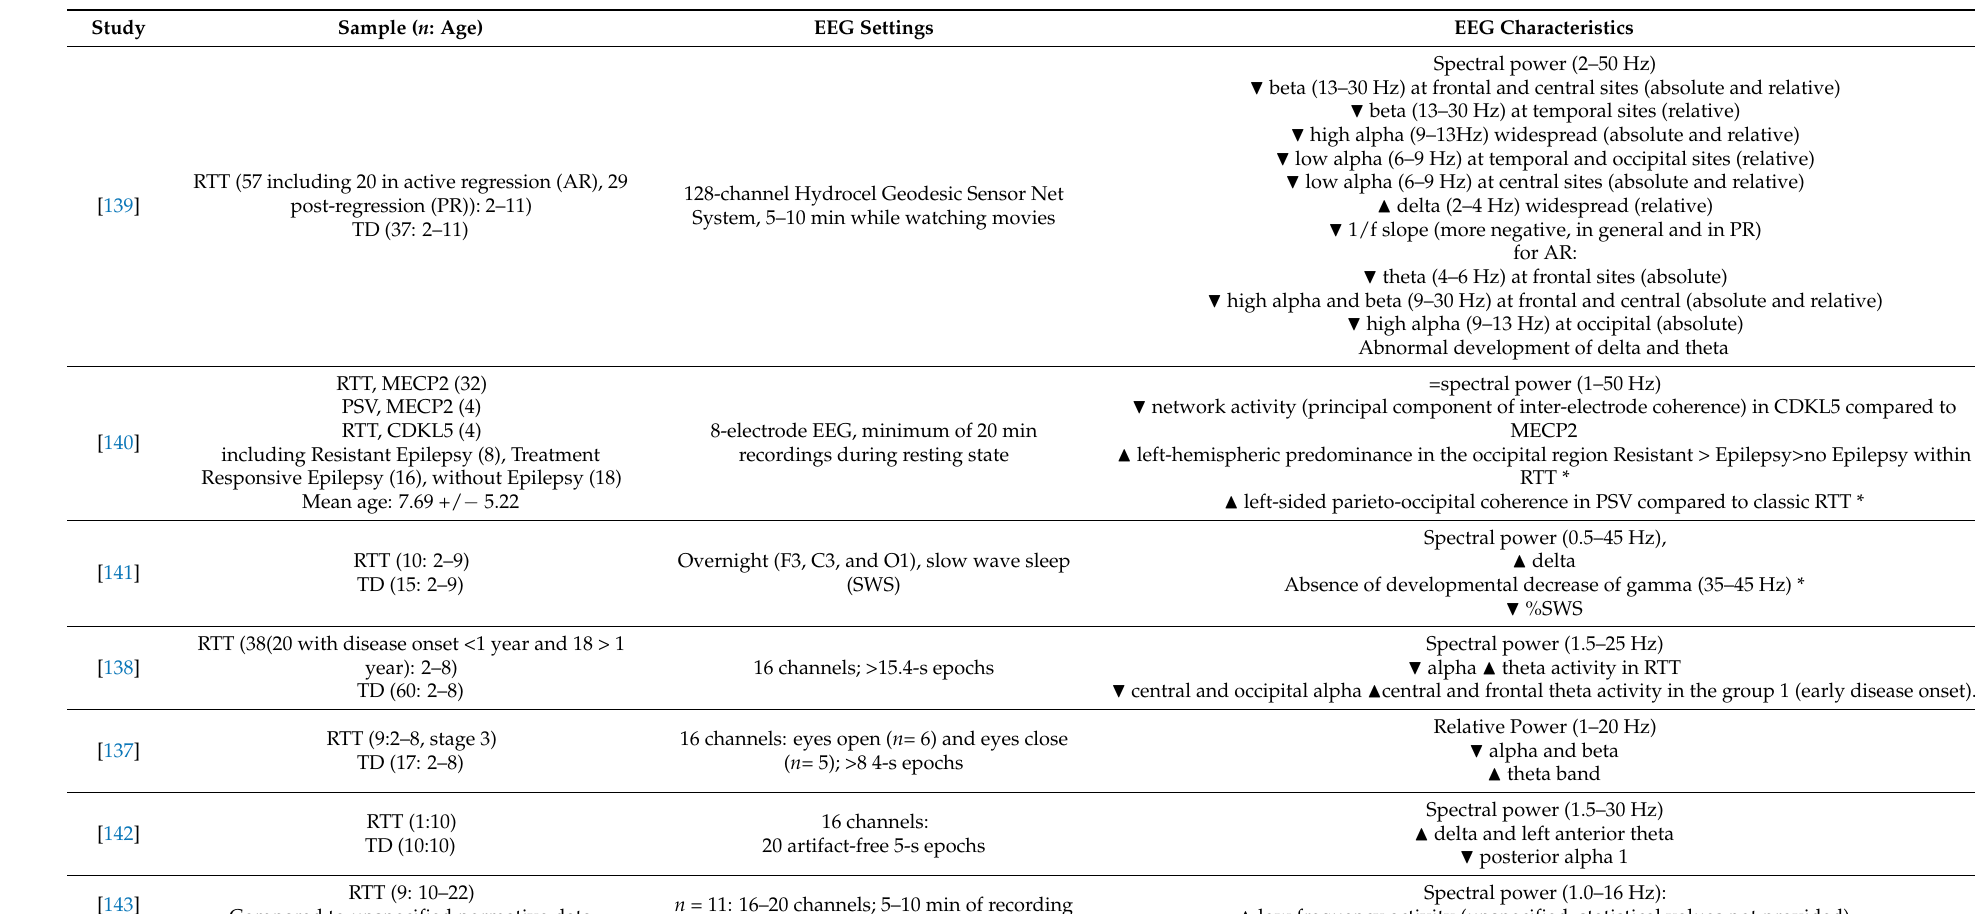
Table 3. Quantitative EEG studies in patients with